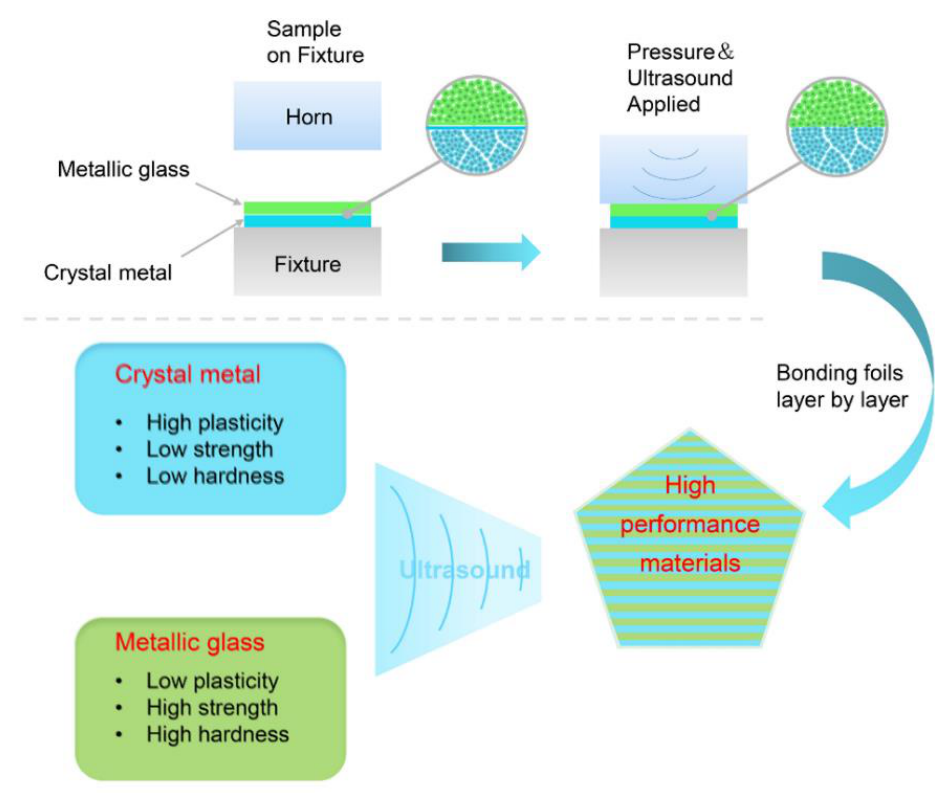
Figure 1. Schematic of ultrasonic bonding additive manufacturing.